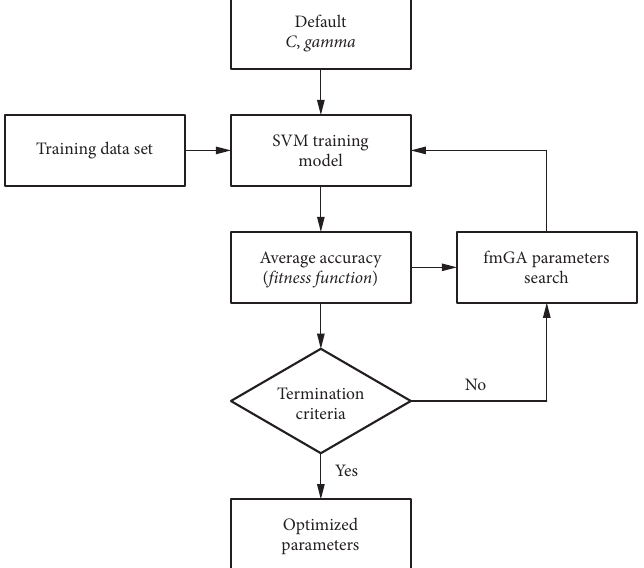
Figure 1. Evolutionary support vector machine inference model (source: Cheng & Wu,